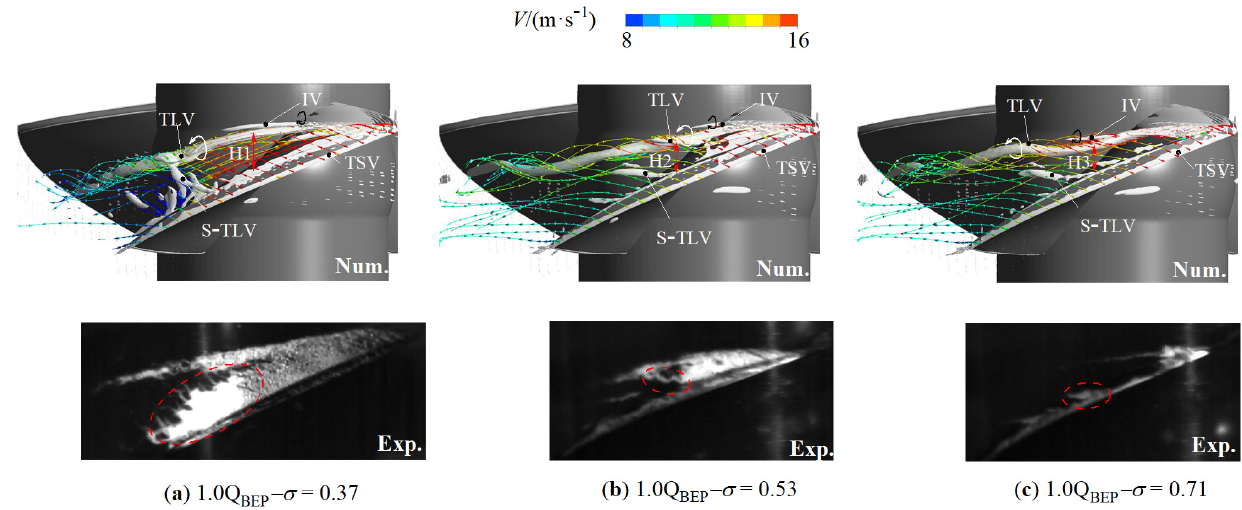
Figure 11. Schematic diagram of S-TLV under standard flow conditions, as shown by numerical simulation and experimental results.